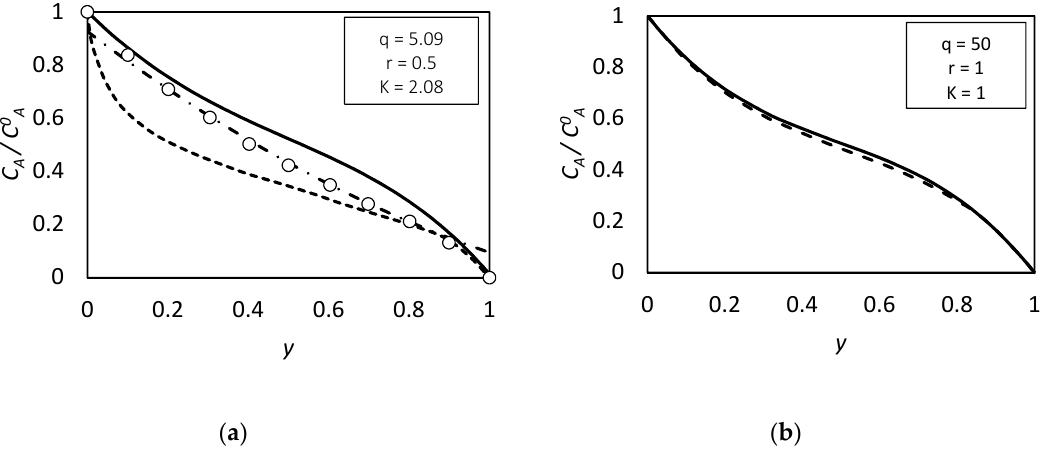
Figure 7. Solute concentration profiles. ( a ) δ = 22.5, circles are numerical solution from Jain and Shultz [58], solid line is the upstream solution, broken line is the downstream solution, dash dotted line is the equilibrium core solution; ( b ) δ = 5, solid line is the upstream solution, broken line is the downstream solution. In both cases the downstream solute concentration is